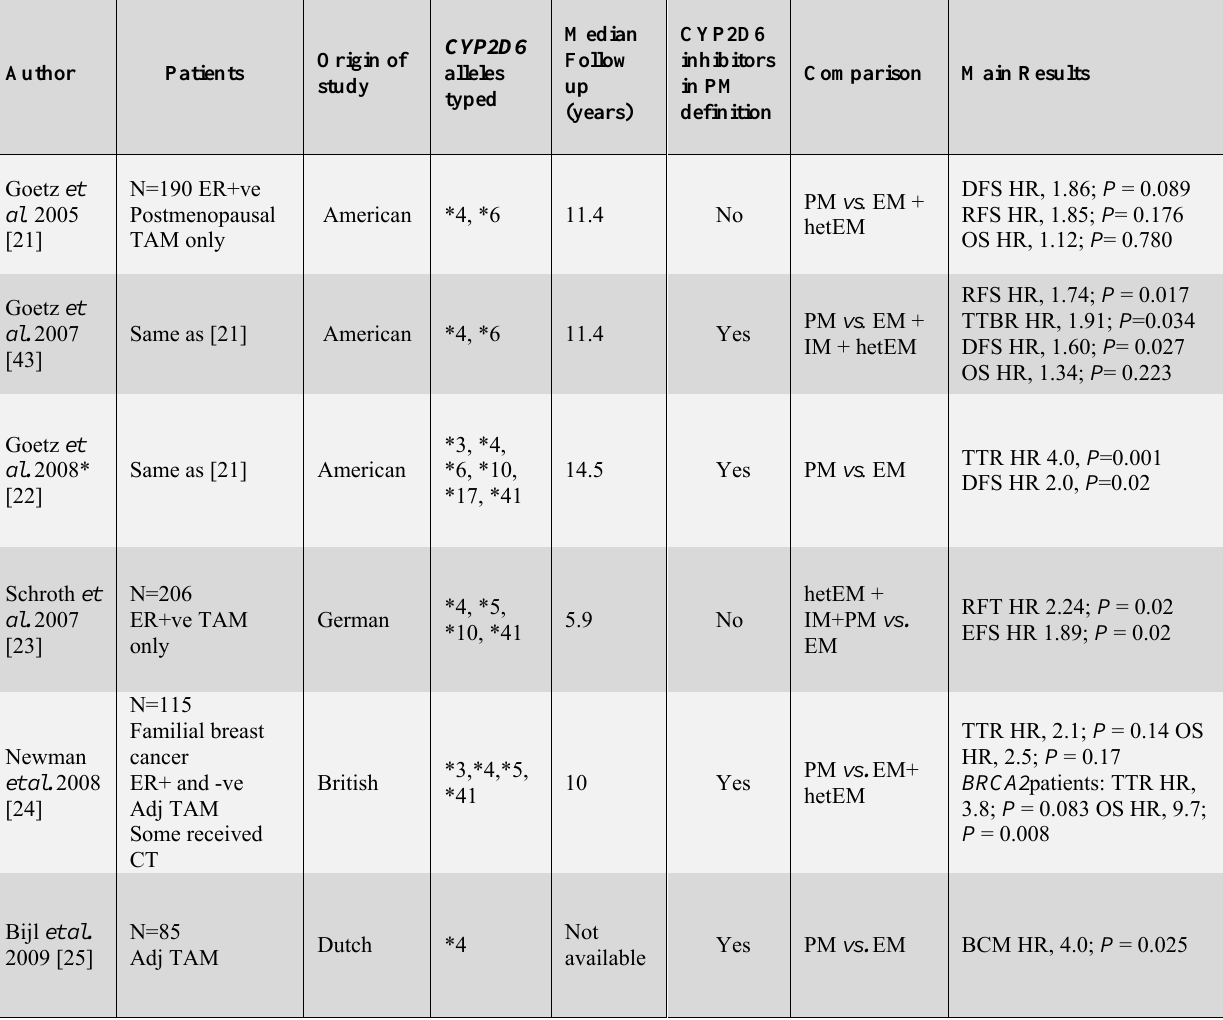
Table 2. Summary of clinical studies that have evaluated the association between CYP2D6 genotype and tamoxifen-related clinical outcome in early breast cancer